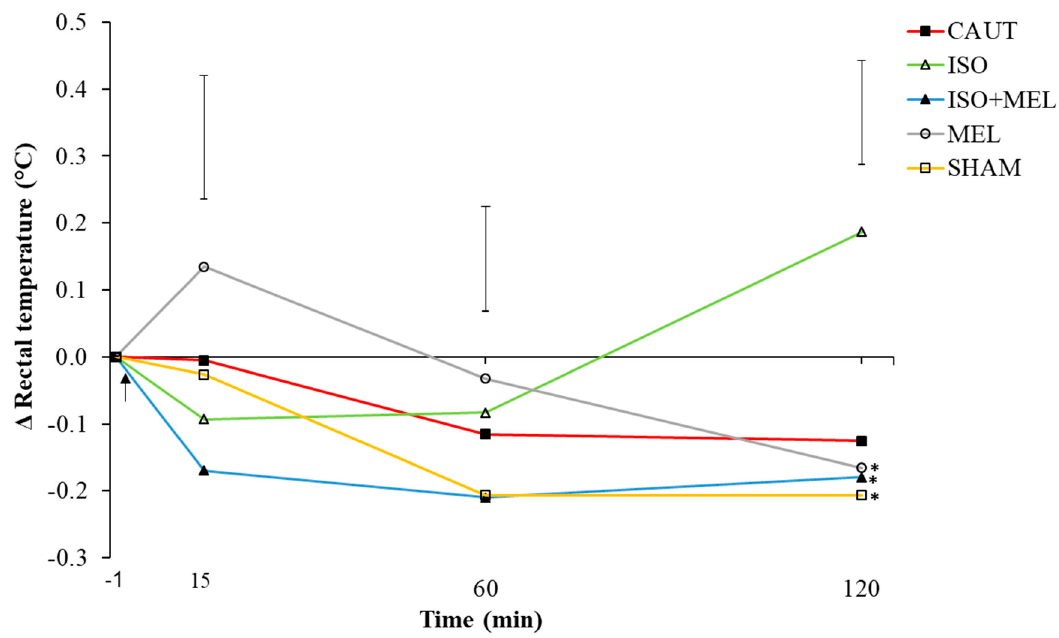
Figure 2. Mean change (± maximum standard error of the difference) in rectal temperature (from baseline; °C) over 2 h post ‐ treatment of goat kids (n = 10/treatment) that were either (i) cautery ‐ disbudded with no pain relief (CAUT), or disbudded following administration of (ii) isoflurane (ISO), (iii) meloxicam s.c. and isoflurane (ISO + MEL) or (iv) meloxicam s.c. alone (MEL). (v) Sham ‐ handled kids (SHAM) acted as controls. Asterisks represent means that differ from ISO kid means within each time point at p ≤ 0.05. Arrow indicates time of treatment.